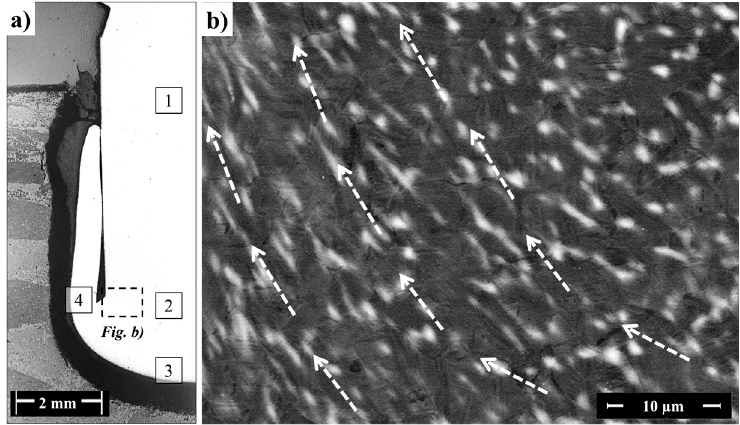
Figure 15. ( a ) Optical image from the cross-section of the HEI joining condition; ( b ) backscattering SEM image of Region 2 near the transition to Regions 3 and 4 showing β -fleck patterns. Arrows in ( b ) indicate the direction of the material flow associated with rivet plastic deformation during the forging phase.